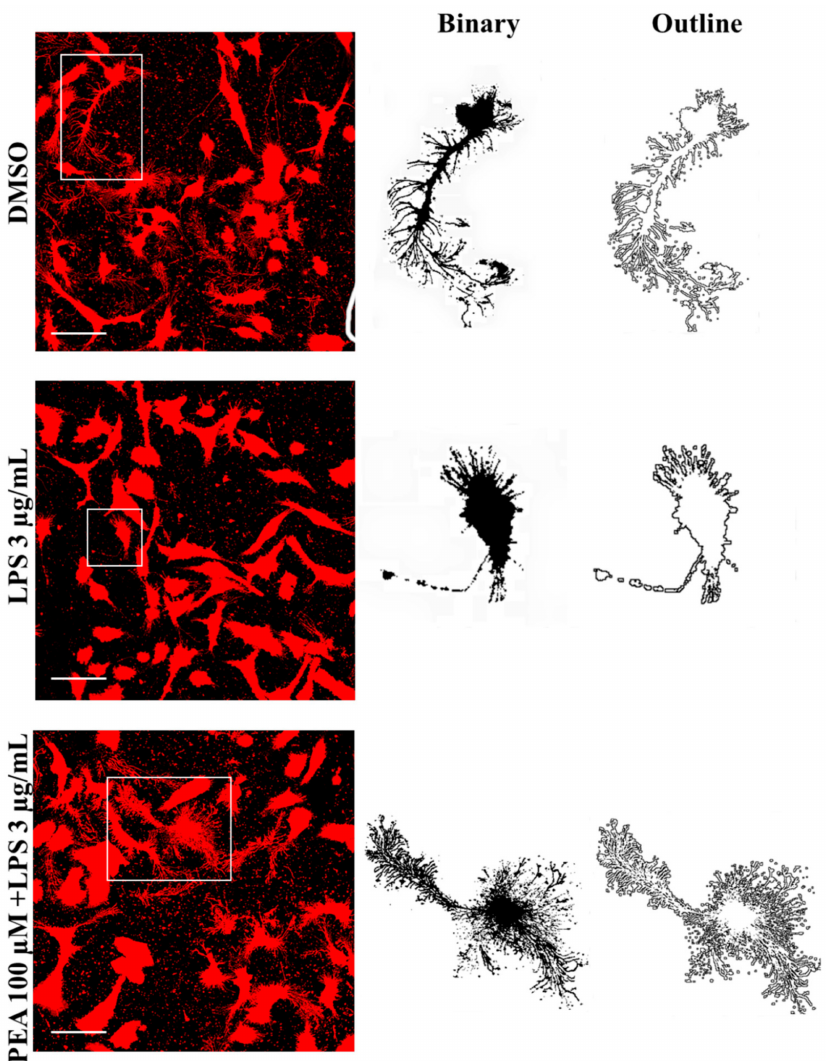
Figure 4. Effect of PEA on microglia morphology in LPS-stimulated N9 cells. N9 cells were seeded on porcine gelatin pre-treated coverslips and then were incubated with 100 µ M PEA at 1 h before treatment with 3 µ g/mL LPS for 6 h. Cells were stained with the membrane dye DiI and fixed. Fluorescence images were acquired by a 63 × magnification on Leica TCSSP2 laser scanning confocal microscope. On the right, examples of cell outlines. Scale bar: 50 µ